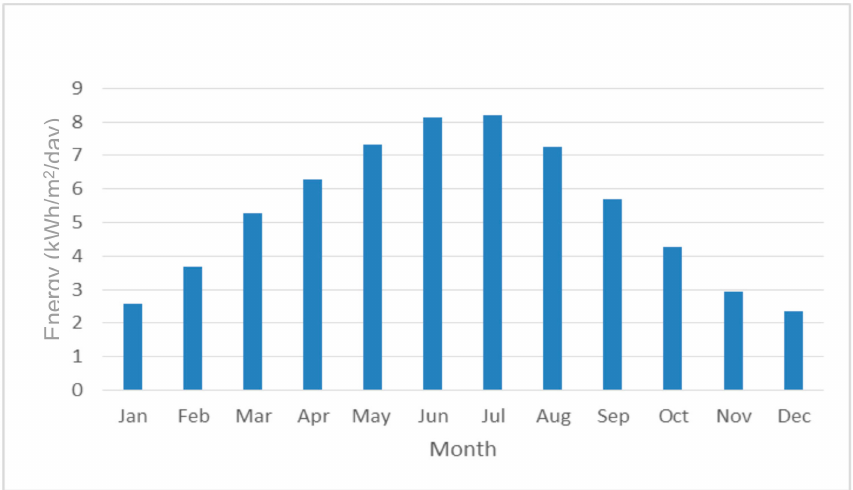
Figure 25. Monthly global solar irradiance during 2018 at Casa del Carmen